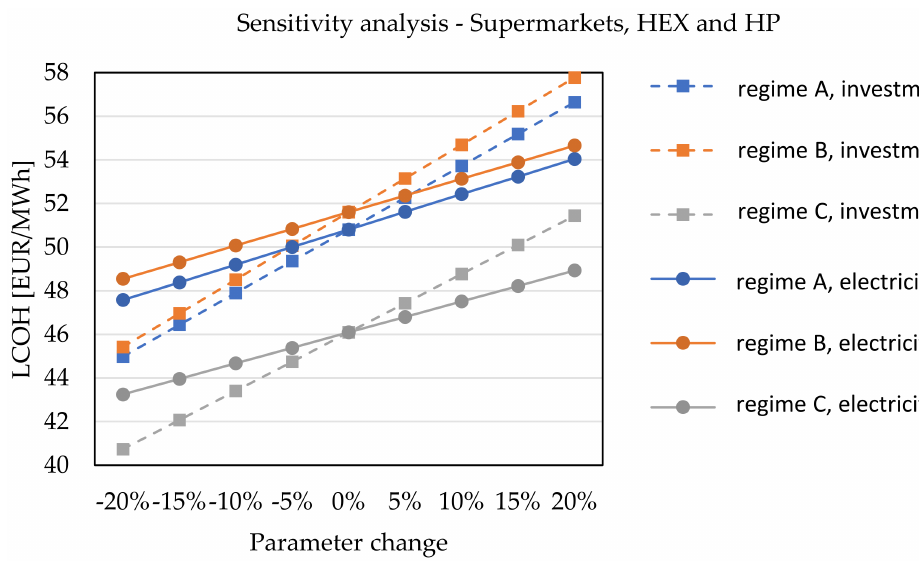
Figure 24. Sensitivity analysis for different DH network temperature regimes—supermarkets waste heat, utilization technology heat exchanger and heat pump.